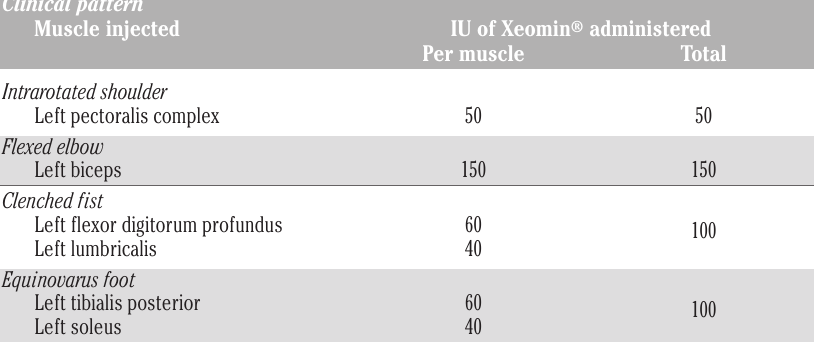
Table 1. Doses of Xeomin ® administered to individual muscles. Clinical pattern Muscle injected